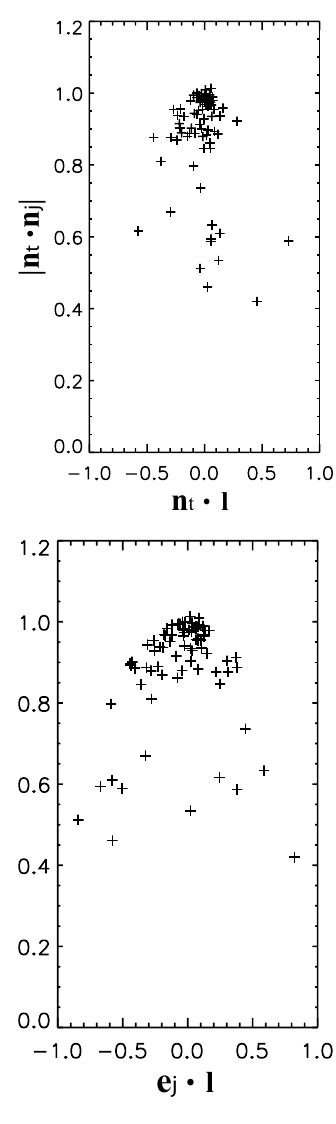
Fig. 8. Mutual orientation of the main magnetic field direction l , timing normal n t , and n j = l × j /j